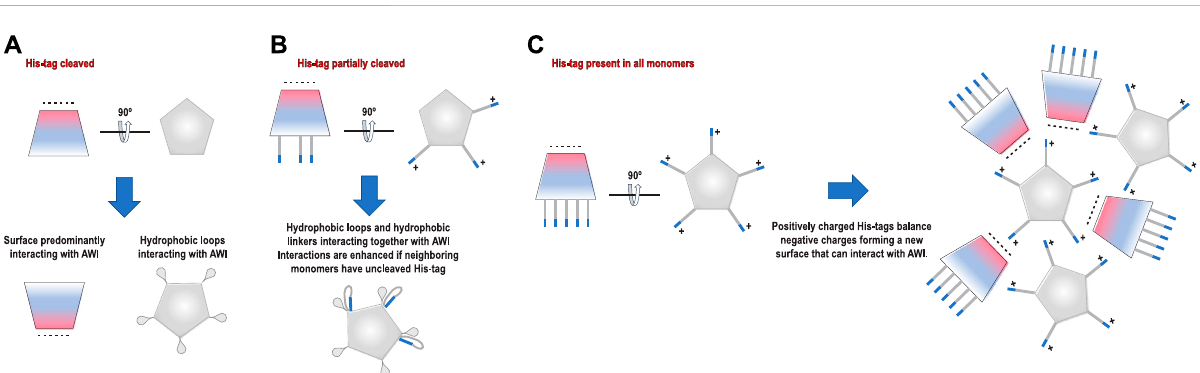
FIGURE 6 Proposed models of interactions with the AWI for each sample. (A) Particles with His-tag cleaved interact with the AWI using predominantly a hydrophobic “ bottom ” surface. (B) ParticleswithHis-tagpartiallycleavedinteractwiththeAWIusingahydrophobicloopwithinteractionsmostlikely enhanced by the hydrophobic linker between the N-terminus of the protein and the His-tag. (C) Particles with His-tag present in all monomers interact with the AWI using the predominantly negatively charged side of the molecule. This can be achieved if the positively charged His-tag compensates the negative charge on the other surface, forming a new interface that can interact with the AWI.